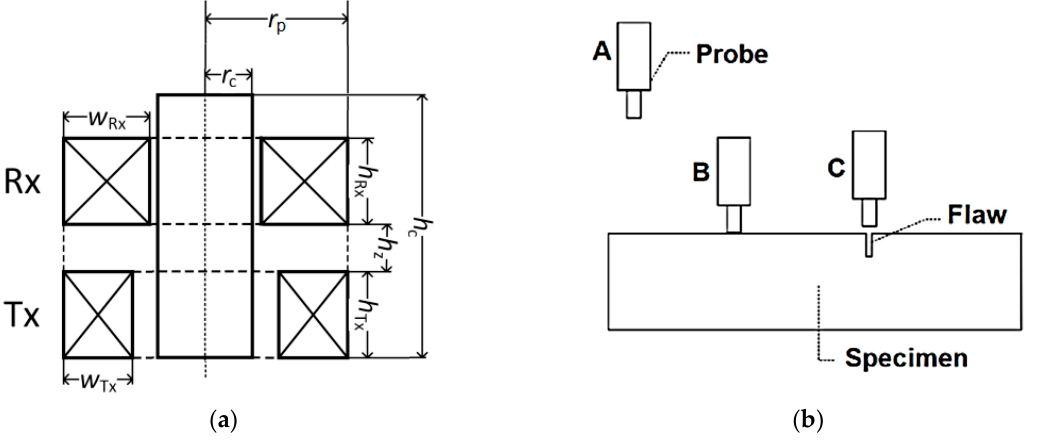
Figure 2. The probe used in experiments ( a ) and probe positioning ( b ). Material specimens used for the experiments are made of stainless steel, marked AISI 316L (austenitic stainless steel, without titanium stabilization, low Carbon content). The plates are all the same thickness, h = 10 mm. The width of the plate is w = 115 mm, and the length is l = 200 mm. Each plate contains a corrosion crack, Figure